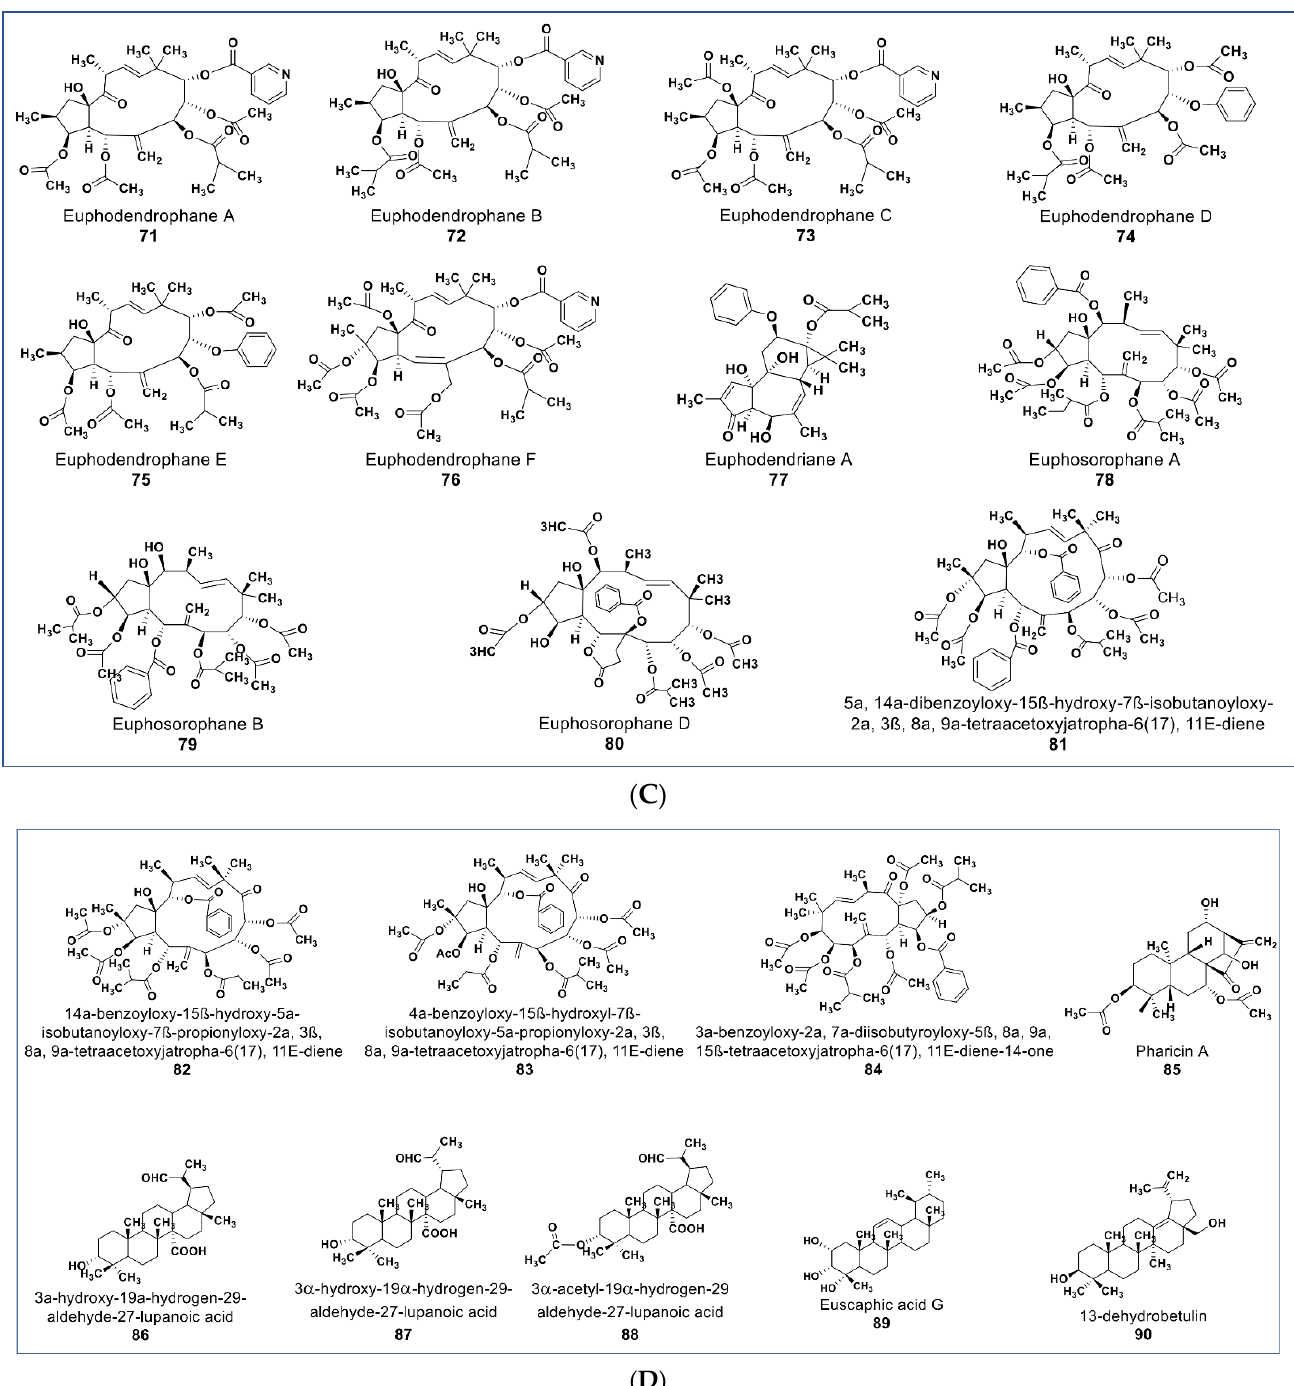
Figure 6. ( A ): Representative members of new terpenoid phytochemicals from various plant sources (compounds 43 to 57 ). ( B ): Representative members of new terpenoid phytochemicals from various plant sources (compounds 58 to 70 ). ( C ): Representative members of new terpenoid phytochemicals from various plant sources (compounds 71 to 81 ). ( D ): Representative members of new terpenoid phytochemicals from various plant sources (compounds 82 to 90 ).